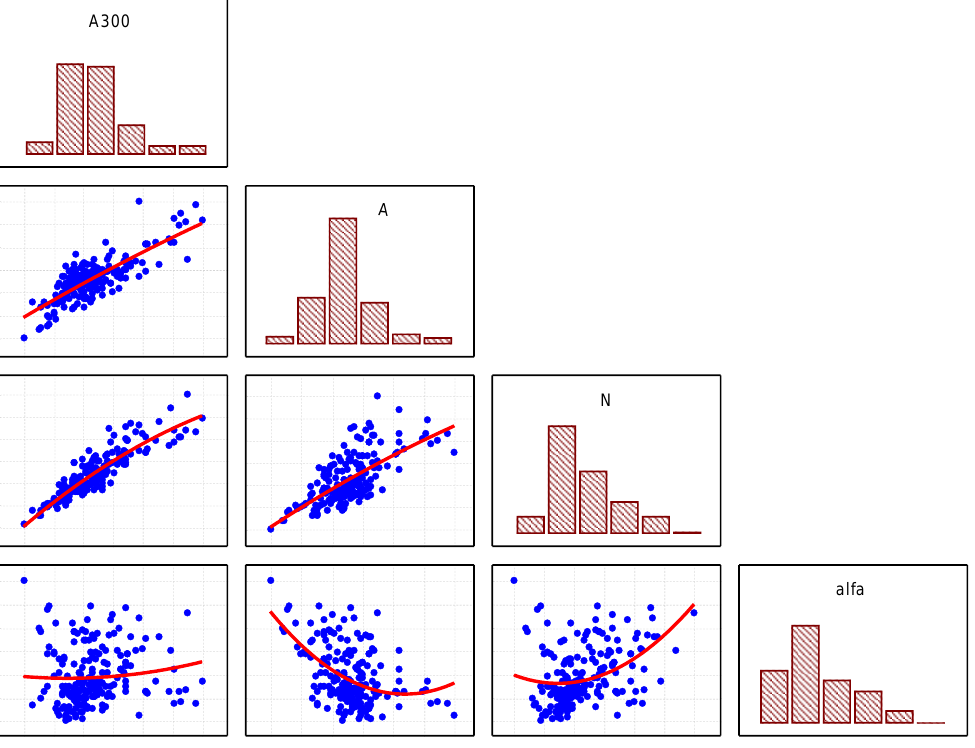
Figure 2. Matrix diagram showing the relationships between factors A, A 300 , α , and N (the column variables are used as X coordinates and the row variables represent the Y coordinates).